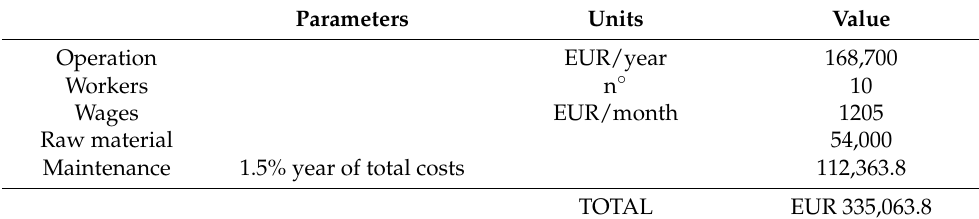
Table 11. Costs associated with maintenance, operation, and feedstock.